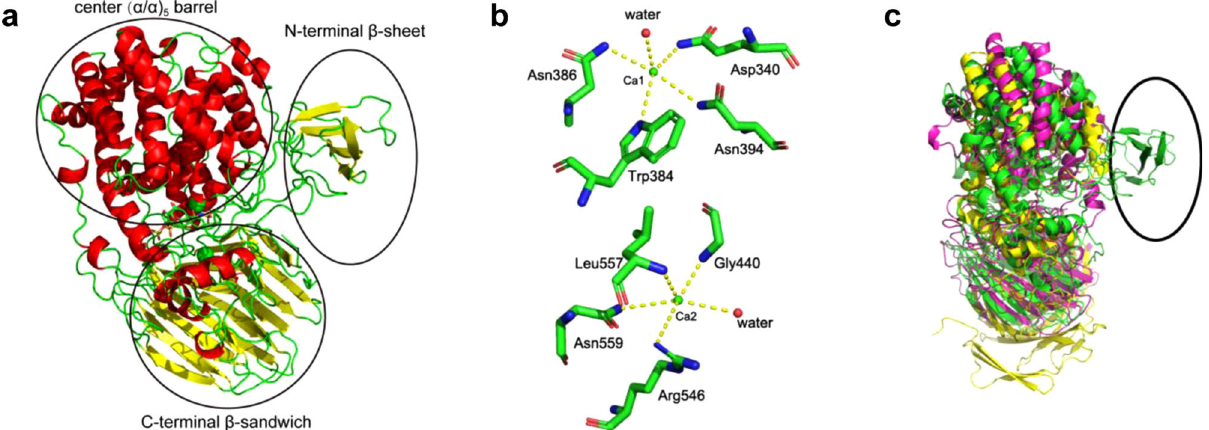
Fig. 3 Overall structure of BIexoHep. a Overall structure (stereo diagram) of BIexoHep. α -Helices and β -sheets are colored red and yellow, respectively. The three domains are labeled with elliptical coils. b Ca 2 + binding sites. The pentacoordination of Ca1 and Ca2 ions in the BIexoHep structure. A cut off distance of 3.5 Å was applied to choose neighboring residues. The distances between the residues and Ca1 atom are as follows: NE2 Asp340 , 3.2 Å; NE1 Trp384 , 3.3 Å; ND2 Asn386 , 3.1 Å; ND2 Asn394 , 3.3 Å; and water molecule, 3.3 Å. The distances between the residues and Ca2 atom are as follows: N Gly440 , 3.1 Å; NH1 Arg546 , 3.4 Å; N Leu557 , 3.3 Å; ND2 Asn559 , 3.5 Å; and water molecule, 3.2 Å. c Structural overlap of BIexoHep with Hepase II and Hepase III from P. heprinus DSM 2366. The structures are shown as cartoons, and Hepase II (PDB code 2FUT), Hepase III (PDB code 4MMH) and BIexoHep (PDB code 6LJL) are colored pink, yellow, and green, respectively. The additional N -terminal β -sheet domain of BIexoHep is labeled with an elliptical coil.